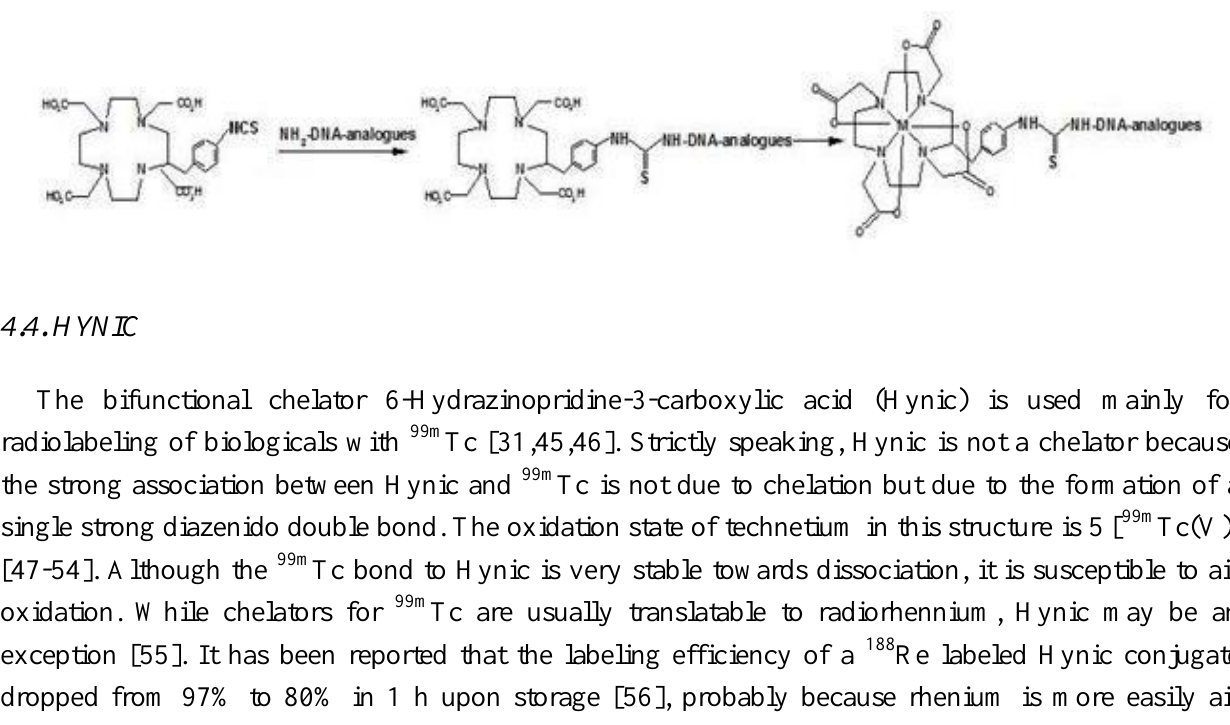
Figure 5. Conjugation of the SCN-benzyl-DOTA to amine-derivatized oligomers, and